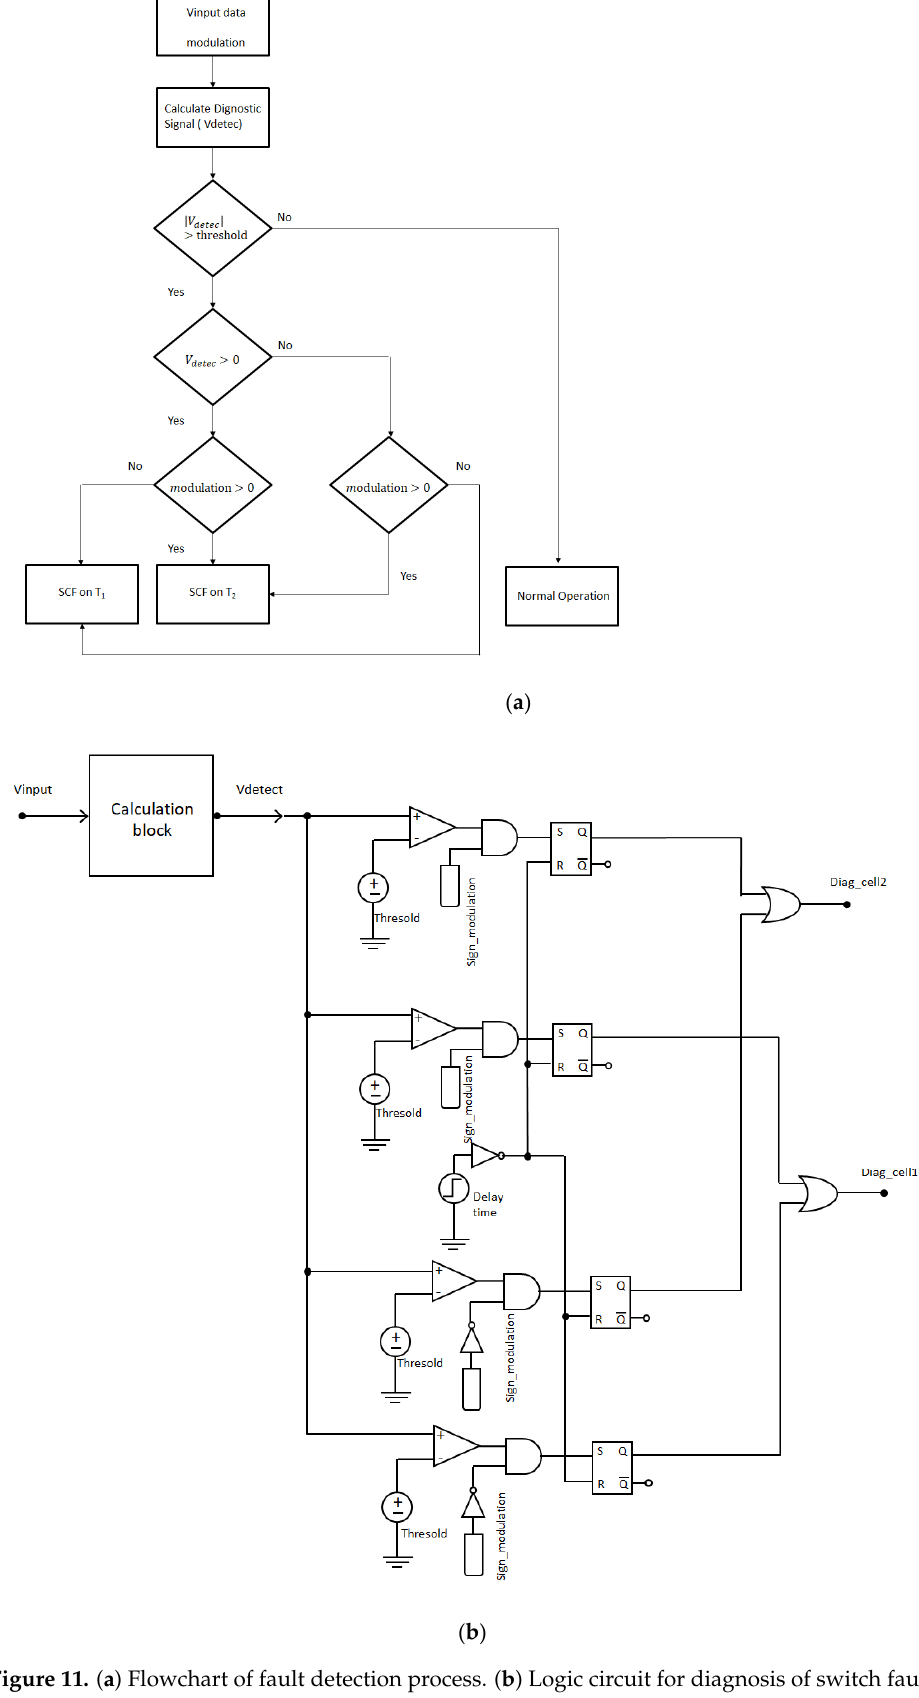
Figure 11. ( a ) Flowchart of fault detection process. ( b ) Logic circuit for diagnosis of switch fault.